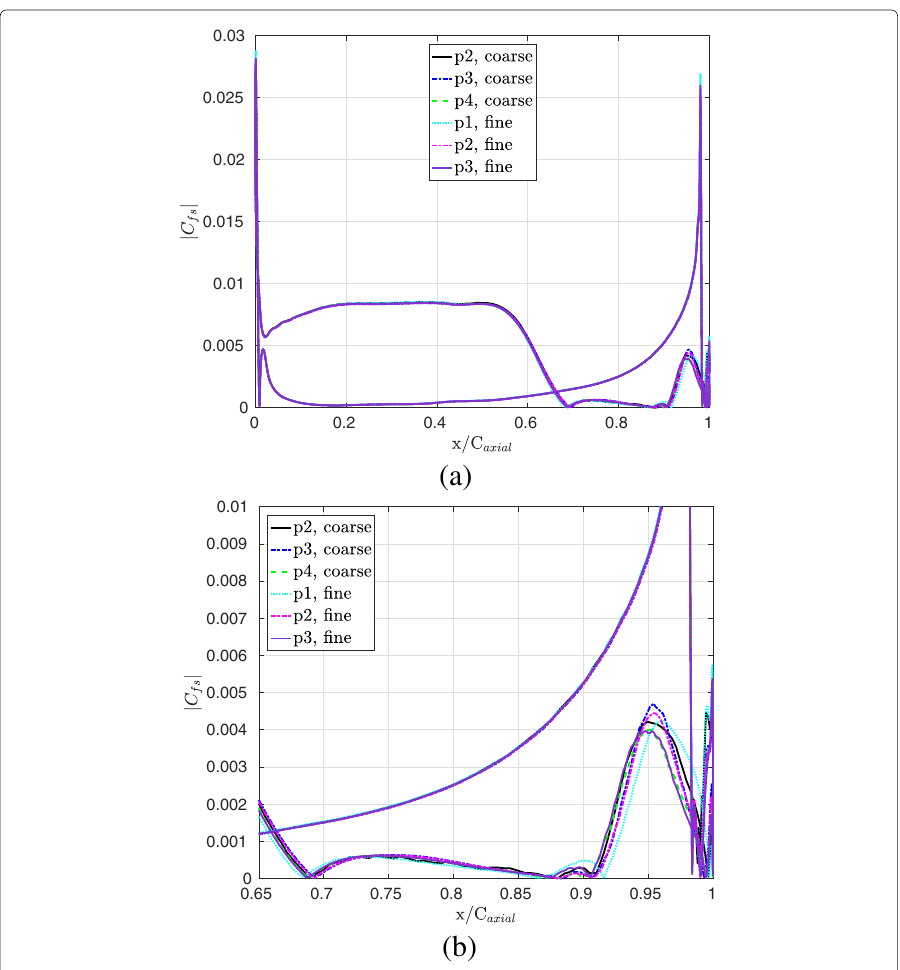
Fig. 6 Comparison of the time- and spanwise-averaged coefficient of the streamwise friction C fs for all meshes and polynomial orders. ( a ) global view over the blade ( b ) enlarged view near the trailing edge